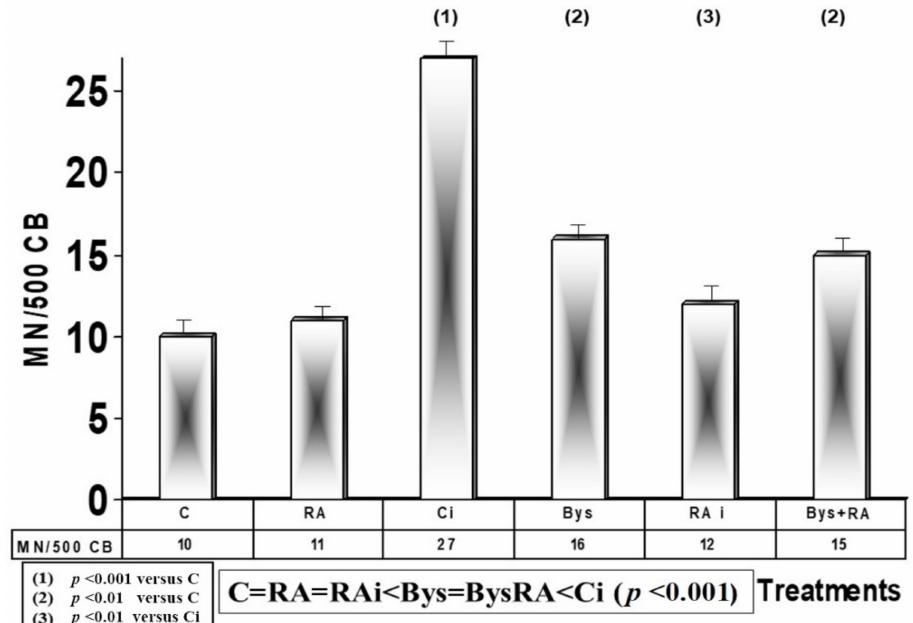
Figure 5. Micronucleus frequency in cytochalasin B-blocked irradiated human lympho- cytes (C, control; RA, treated with rosmarinic acid; Ci, irradiated control; RAi, irradiated, previously treated with rosmarinic acid; Bys, treated with the irradiated serum; Bys + RA, treated with irradiated serum, previously treated with rosmarinic